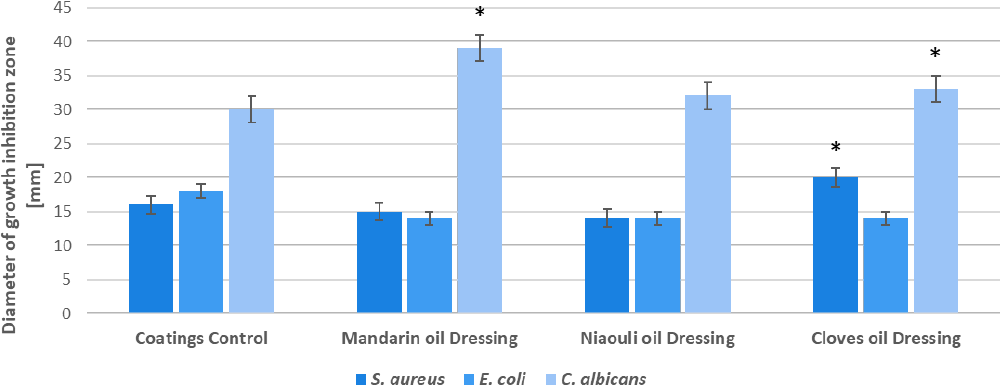
Figure 8. Evaluation of growth inhibition zone for S. aureus , E. coli and C. albicans in the presence of